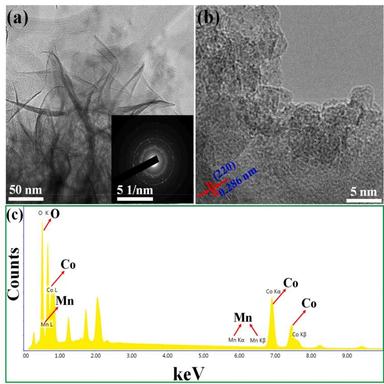
(a and b) Typical TEM and HRTEM images (inset (b) shows the corresponding SAED pattern), and (c) Energy dispersive x-ray analysis (EDAX) elemental mapping analysis of the of the as-developed Mn-Co Oxide NSFAs material.